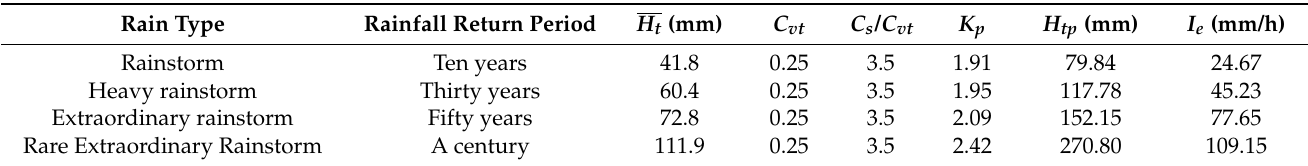
Table 5. Calculation parameters of 1 h rainfall of all rain